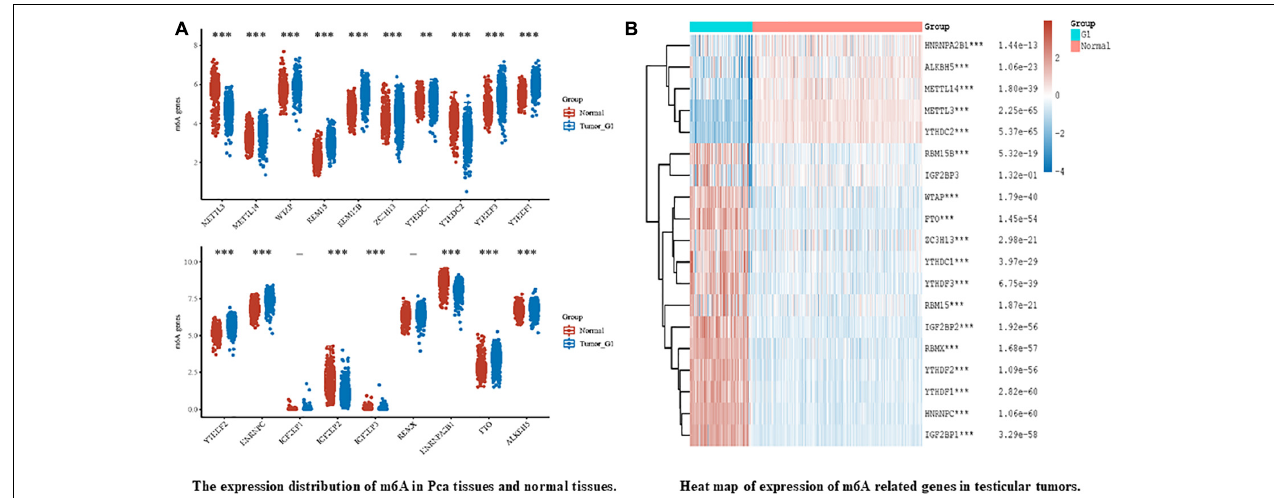
FIGURE 3 | Expression release map and expression heat map of m6A related genes in male genital system tumors, in which different colors represent expression trends of different groups and m6A in different samples. (A) represents the expression of m6A in prostate cancer (Pca) and normal prostate tissue, The blue bar chart represents Pca and the gray bar chart represents normal prostate tissueand. Asterisks represents the correlation. (B) on behalf of the heatmap of m6A-related genes in testicular germ cell tumors (TGCTs). The left part of figure represents TGCTs, and right represents normal testicular germ cell. Heat map color key: red to blue represents decrease of p value. Where “-” represents no significant difference, * p < 0.05, ** p < 0.01, *** p < 0.001. P value less than 0.05 indicates statistically significant results. The significance of the two groups of samples passed the Wilcox test. All data from TCGA and GTEx datasets. All the above analysis methods and R package were implemented by R foundation for statistical computing (2020) version 4.0.3 and software packages ggplot2 and pheatmap.